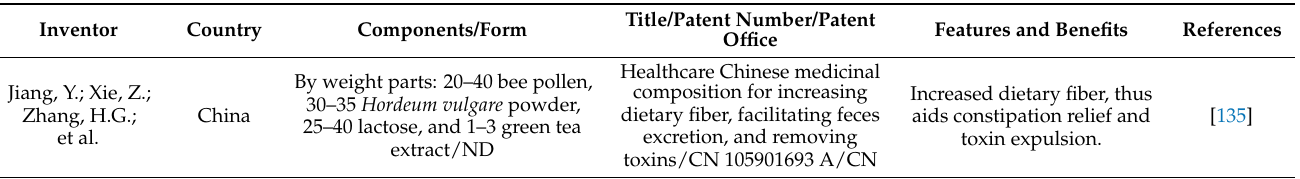
Table 6. Patent forms of bee pollen in food